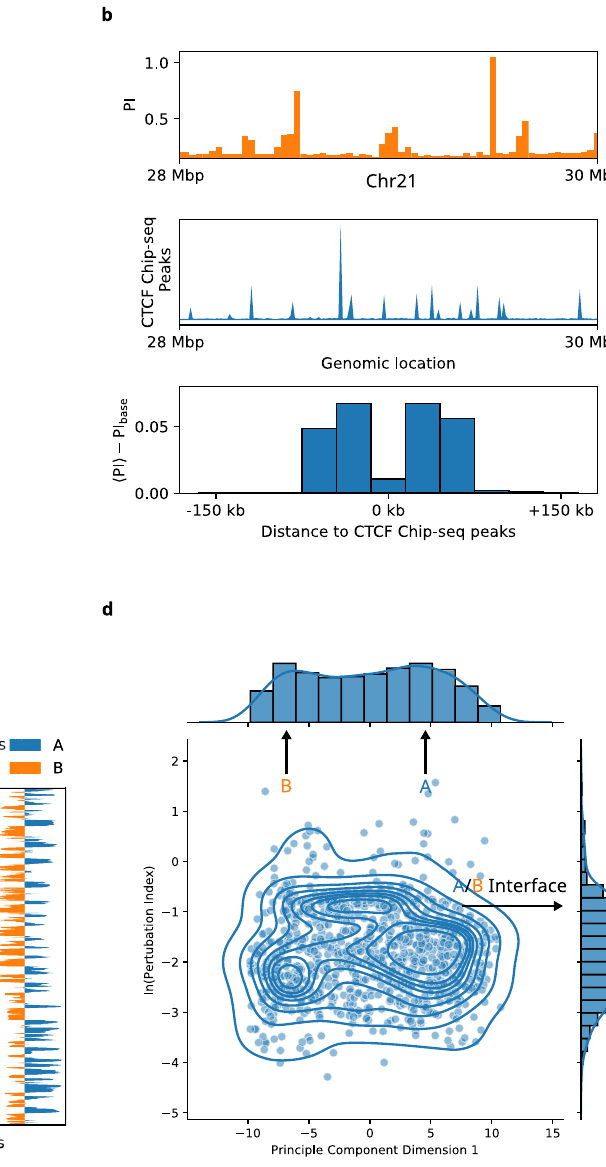
to 150 kbp on either side of CTCF Chip-seq peaks are calculated at 30 kbp resolution. PI base = 0.2. c An example of the contact map with a single locus deletion(uppertriangle)forChr2fromtheIMR90cellline.Thetoppanelshows a track plot of the perturbation index (PI) computed using Eq. (3). d Plot of principal component dimension 1 (computed from ρ ) versus the logarithm of theperturbationindex.A,B,andA/Bboundariesaremarked.HistogramsofPC1 and the logarithm of the perturbation index are shown on the top and side,